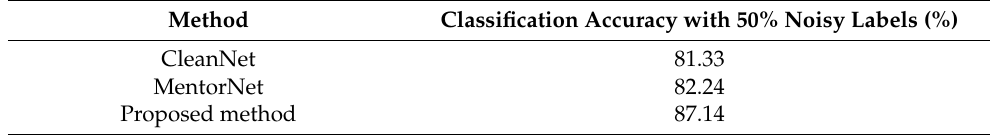
Table 6. Comparisons with recent state-of-the-art label noise learning methods.